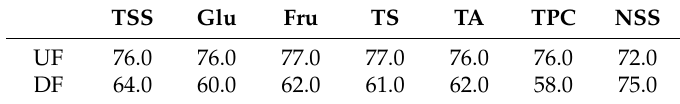
Table 3. Recovery factor R (%) of total soluble solids (TSS), glucose (Glu), fructose (Fru), total sugars (TS), total acids (TA), total polyphenols (TPC), and non-sugar soluble solids (NSS) in retentate after apple-cranberry cloudy juice ultrafiltration (UF) and diafiltration